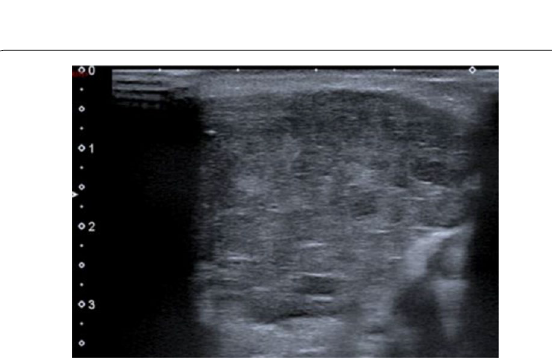
Fig. 19 Acute leukemia. Heterogeneous infiltration leading to bilateral parotid gland enlargement, on ultrasonography